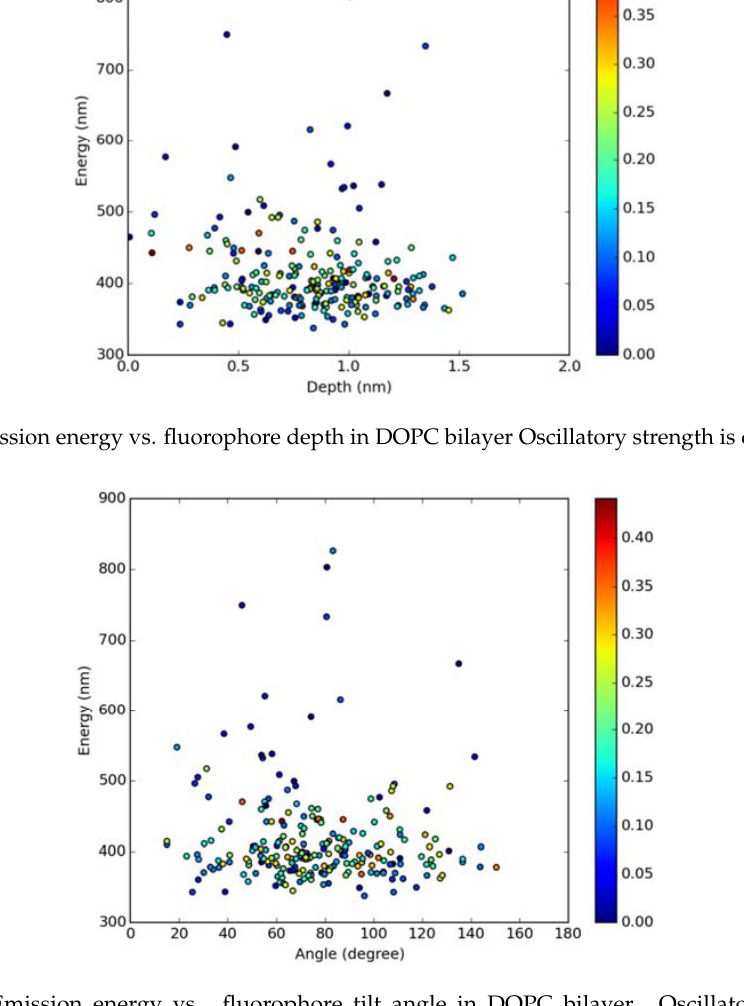
Figure 10. Emission energy vs. fluorophore tilt angle in DOPC bilayer. Oscillatory strength is color ‐ coded.